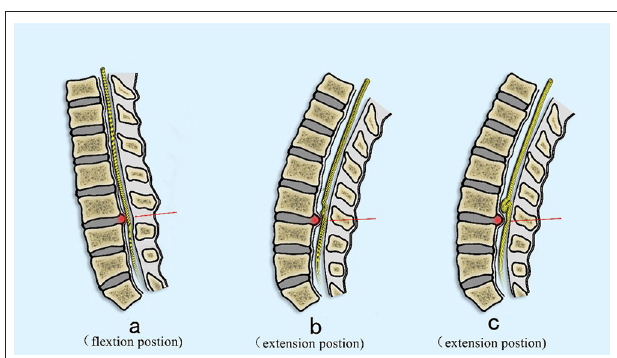
FIGURE 7 | Proposed mechanism of the development of RNRs. (A) The nerve is pulled proximally by the flexed position commonly seen in patients with symptomatic spinal stenosis (arrow). (B) The nerve becomes relaxed in the extended position, but still is deformed at the site of maximal stenosis secondary to a disc extrusion (red arrow). (C) In an extension position, the nerve is redundant cranial to the compressed section but cannot redistribute past the compressed section due to stenosis (red